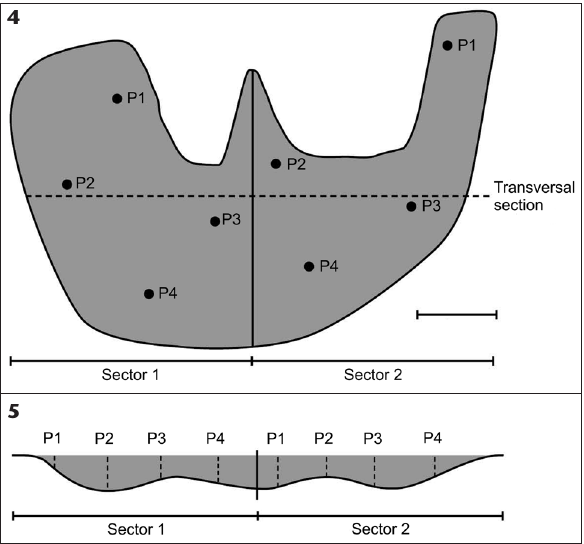
Figures 4-5. Representation of the tide pool division in two sectors [in a top-down (4) and cross-section (5) view] to measure the depth (P1, P2, etc.) whose locations were chosen to best represent the pool’s variability of depth. Scale bar: 1